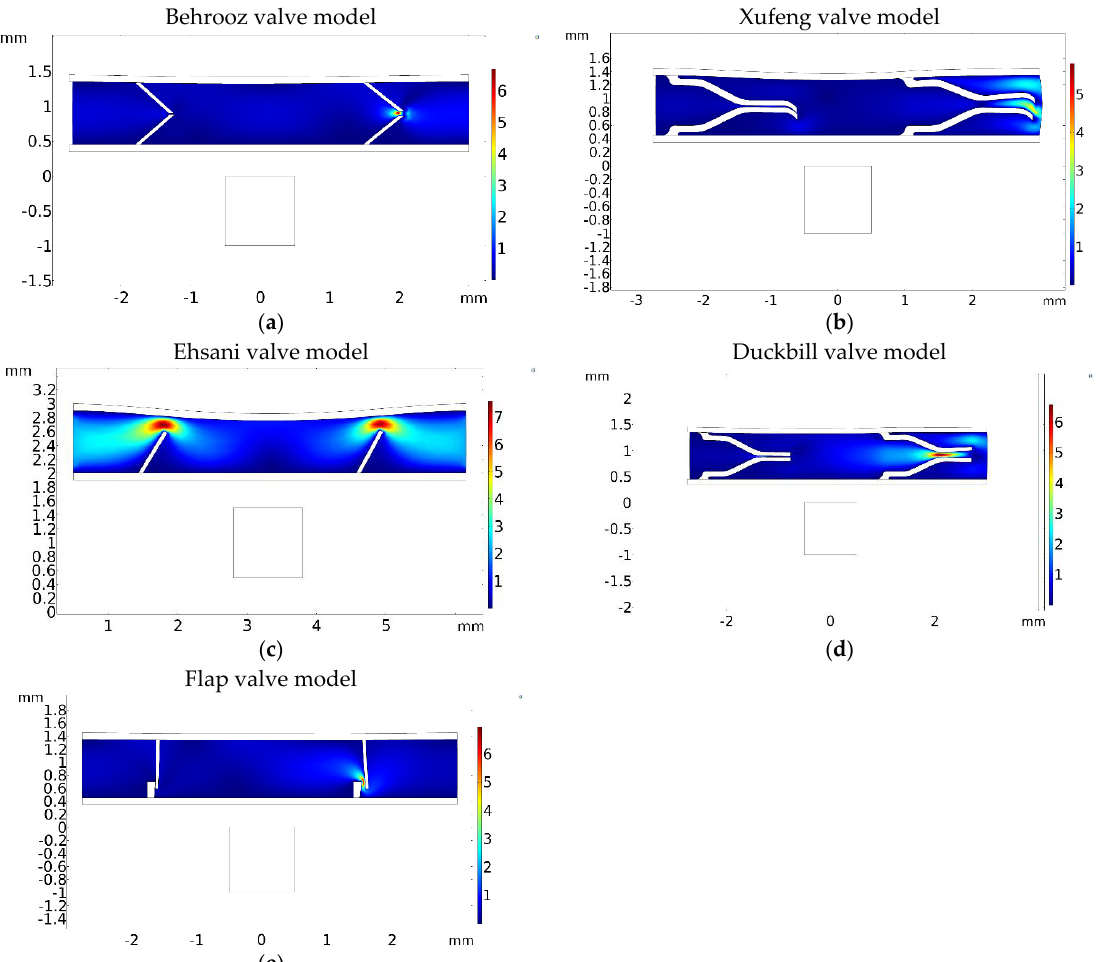
When the upper wall begins to deform downwards it pushes the fluid inside the mi- crochannel towards the two outlets. At this time, the fluid enclosed between the two valves deflects the left and right valves in a way that prevents the backflow, and propels the fluid to the right unidirectionally. This phenomenon is the same for all the five models. Figure 11 shows that the right valve is fully open when the fluid velocity is maximum at the right outlet, and at the same time, the left valve remains closed to prevent the back Figure 10. Vertical displacement of upper MRE wall for five different valve models. flow. This is the same for all five models.